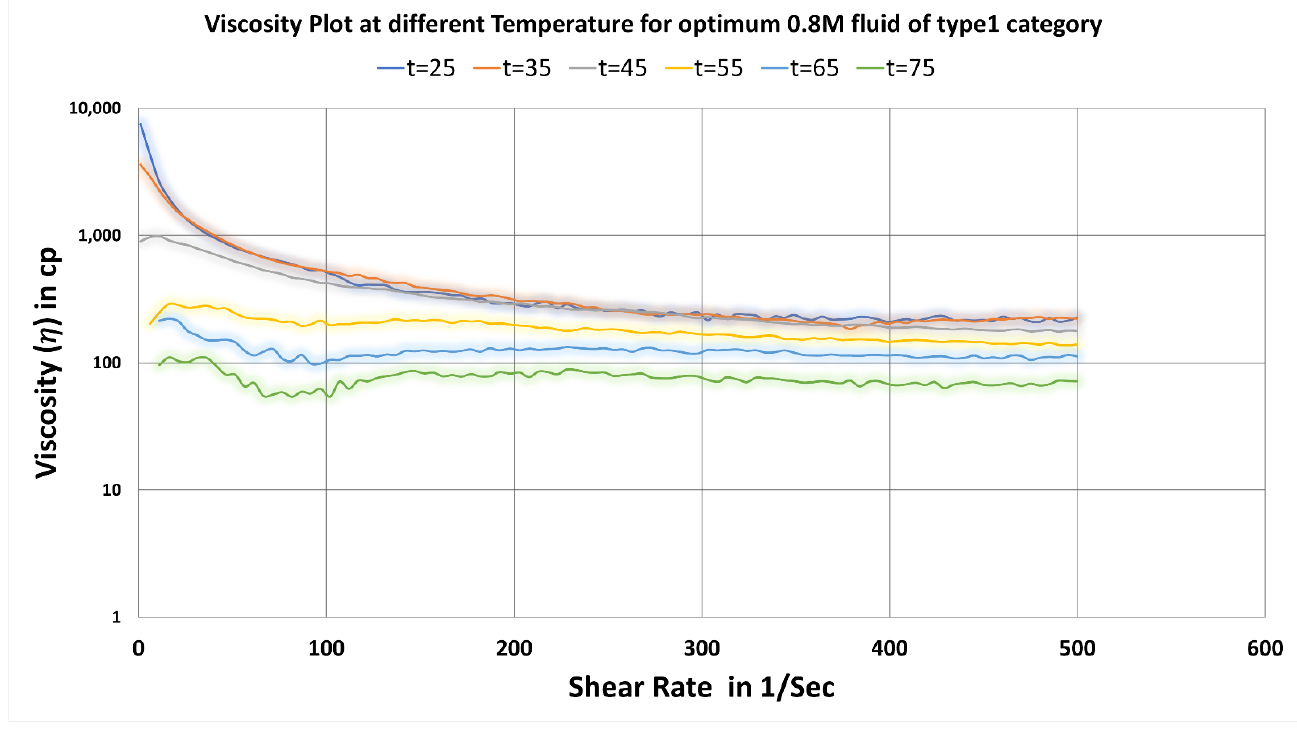
Figure 6. Change in viscosity plot of optimum concentration (0.8 M) of type1 fluids at varying temperatures.